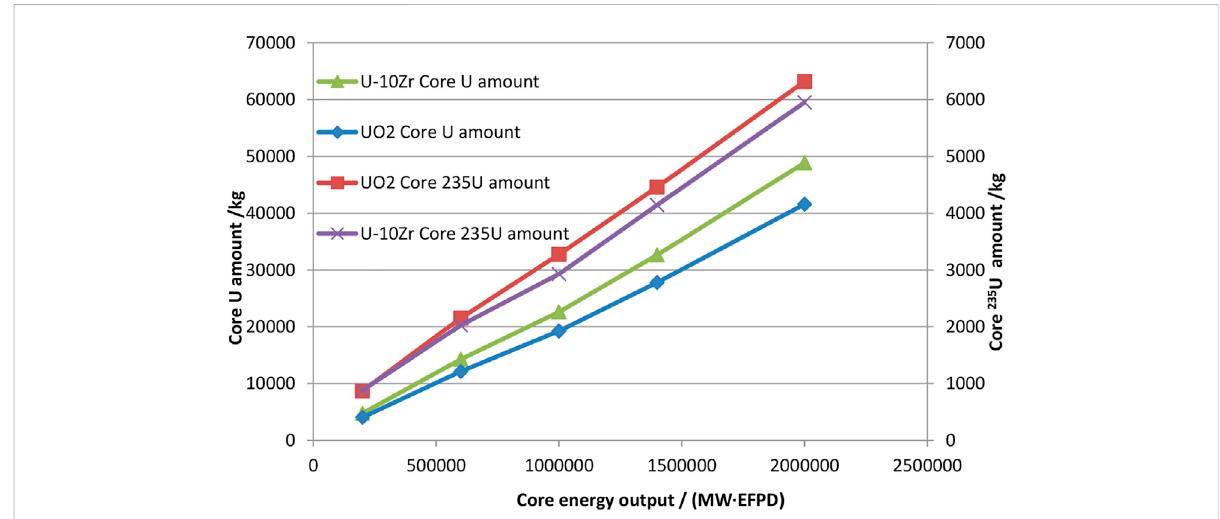
FIGURE 7 Amounts of uranium and 235U of each core scheme changes along the core powers.